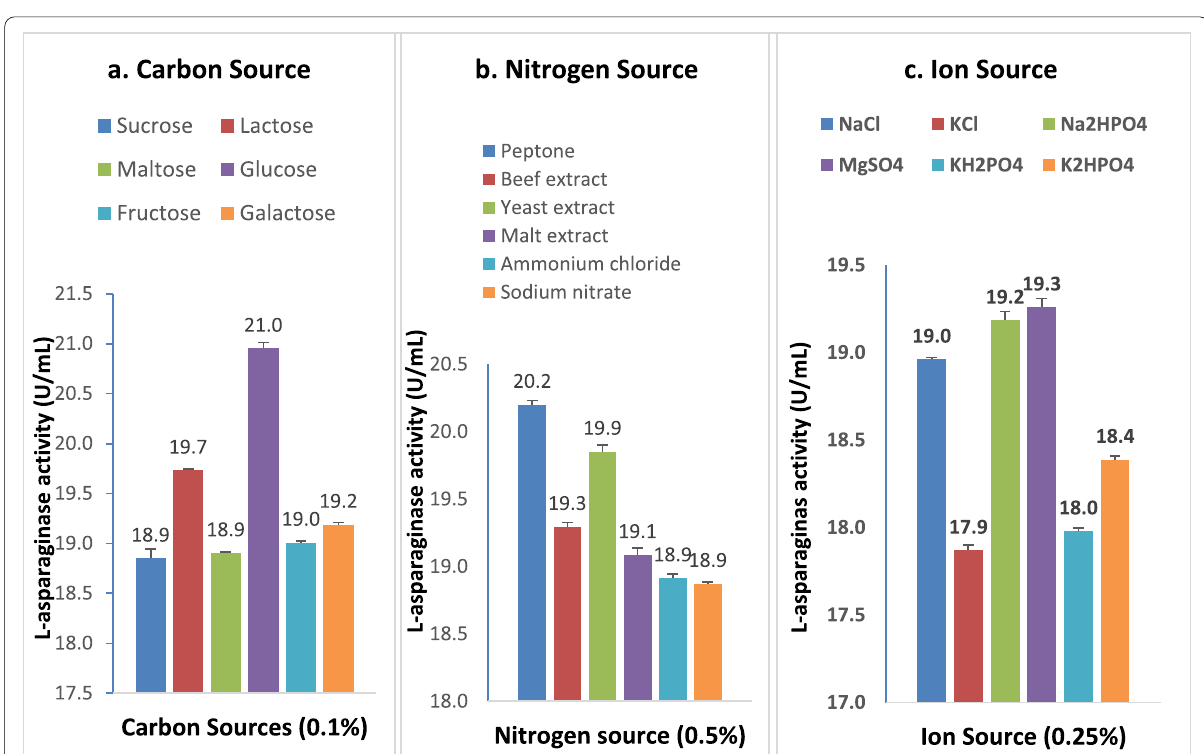
Fig. 2 OFAT optimization of a carbon, b nitrogen, and c ion sources supplementing M9